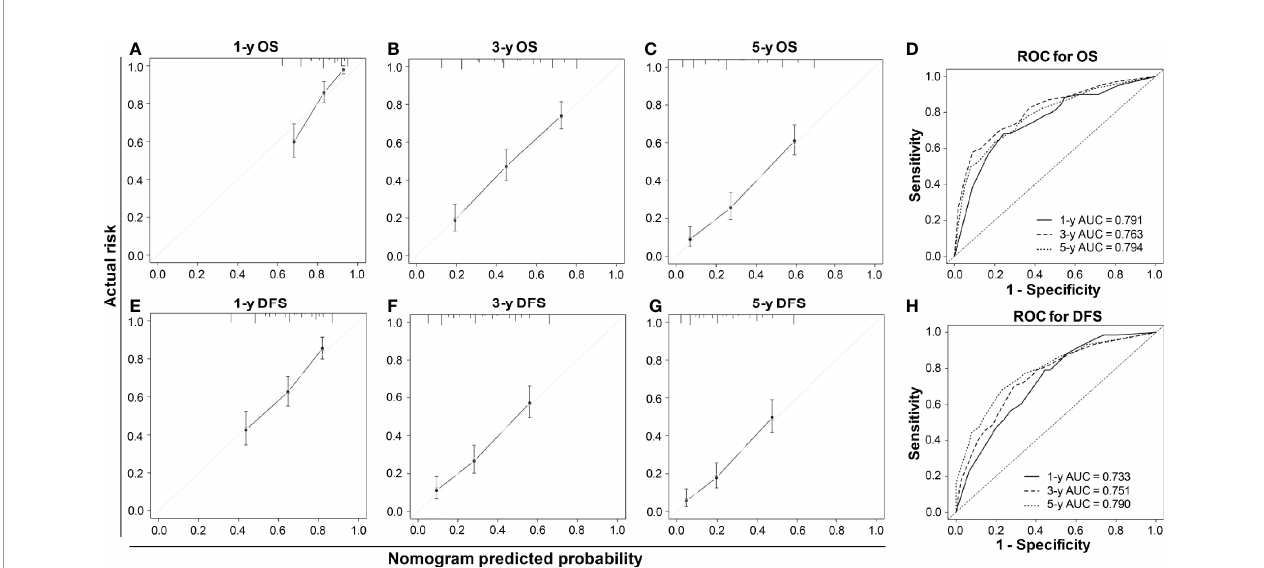
FIGURE 4 | The calibration curves and ROC curves of 1-, 3-, and 5-year OS (A – D) and 1-, 3-, and 5-year DFS (E – H) in the training cohort. For the calibration curve, the x-axis was the predicted-survival based on the nomogram, and the y-axis was the actual-survival; the more the predicted line coincided with the diagonal line, the more accurate the prognosis nomogram would be.